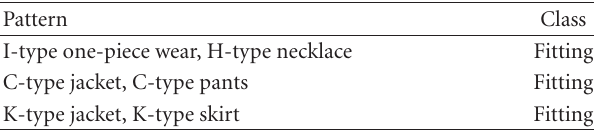
Table 14: Discovered patterns from β